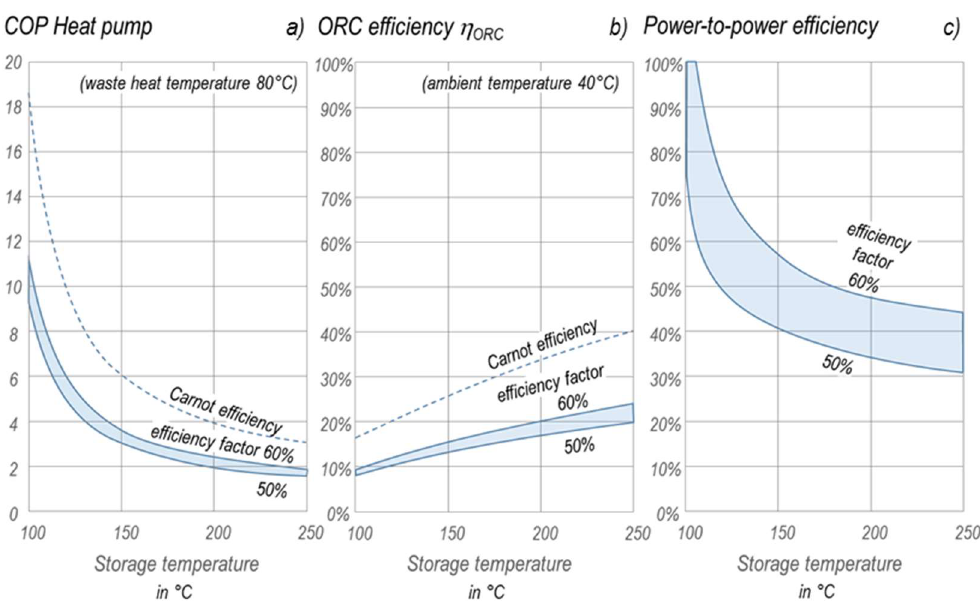
Figure 2. Impact of the storage temperature on the COP of the heat pump ( a ), the efficiency of the ORC ( b ) and the power-to-power efficiency ( c ) of reversible heat pump–Organic Rankine Cycle systems (ORC condensation temperature 40 °C).